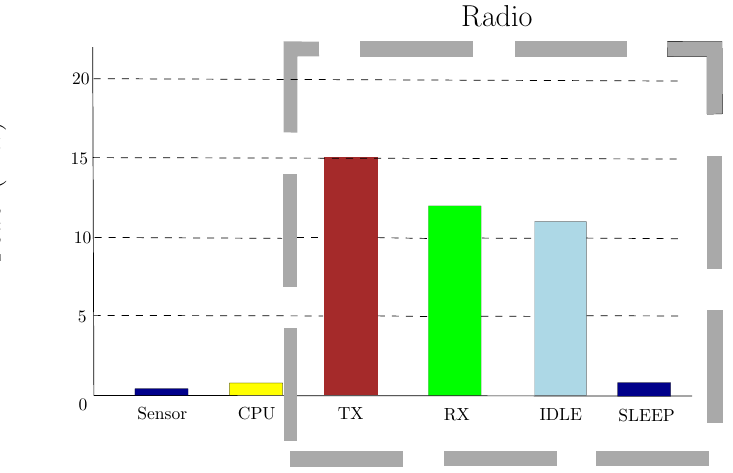
Figure 2. Power consumption of sensor node subsystems